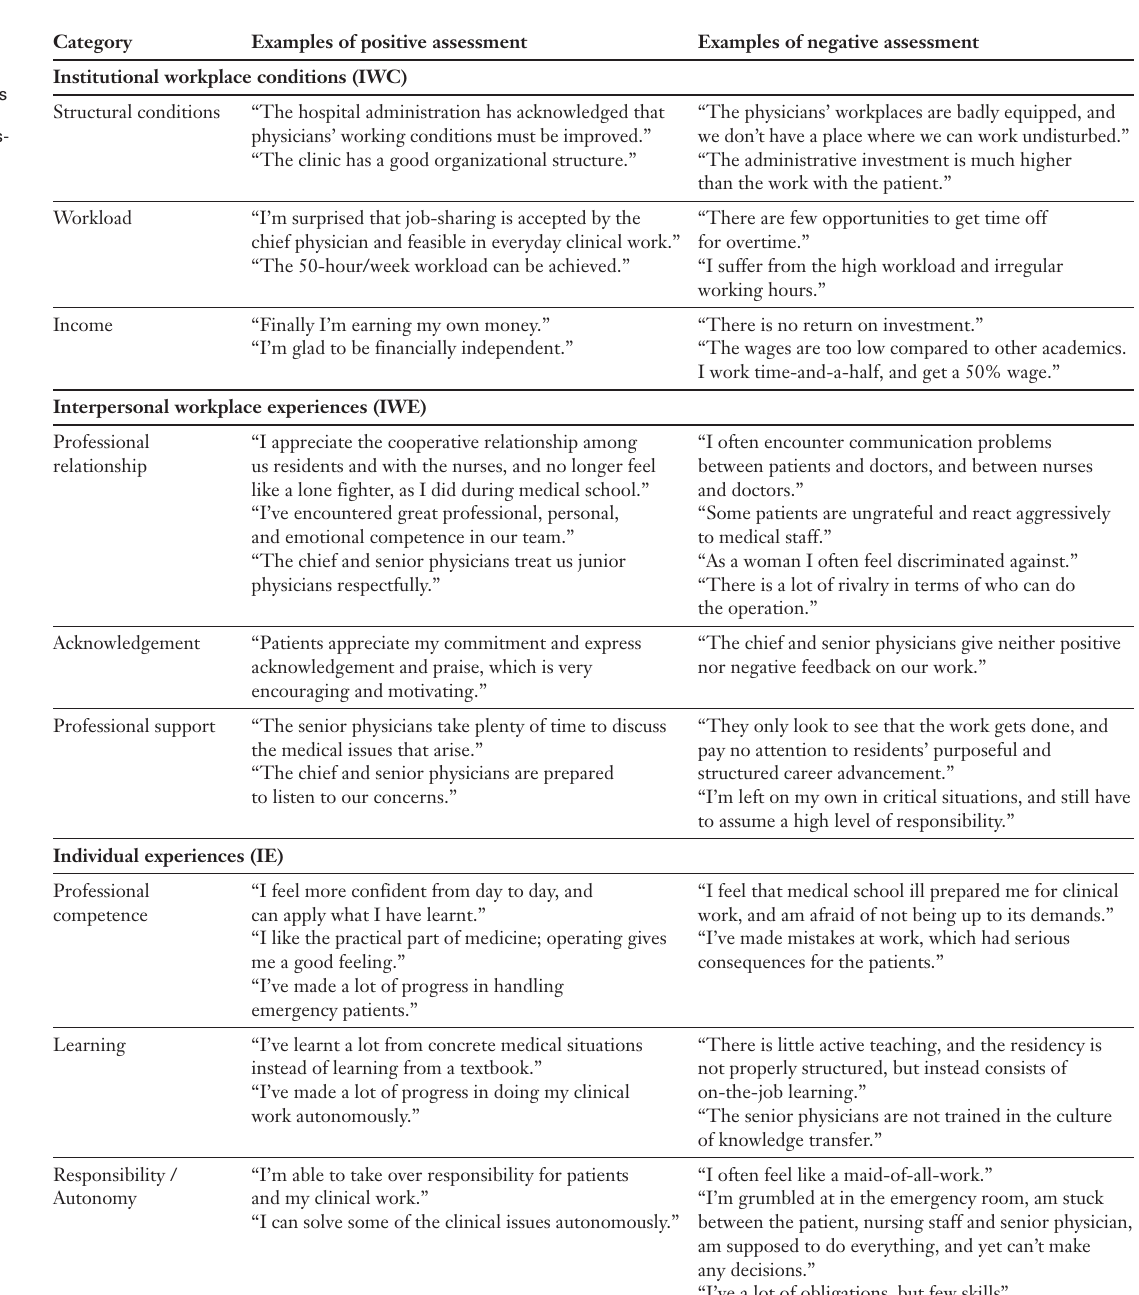
Table 2 Examples of residents’ responses concerning positive and negative assess- ments of career- entry